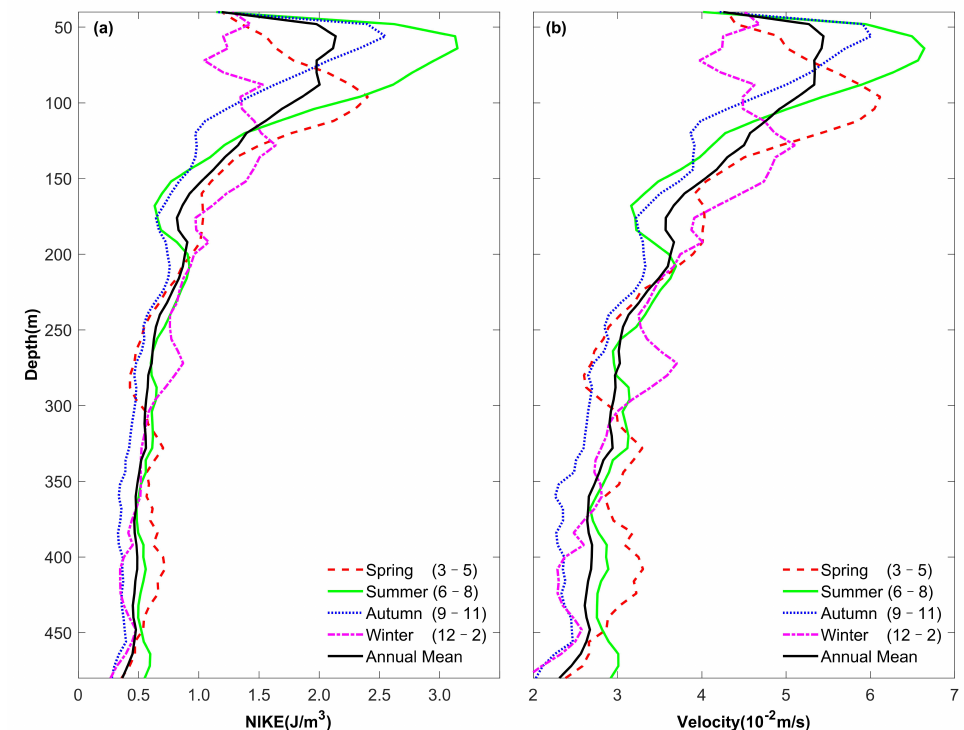
Figure 5. ( a ) Seasonal mean NIKE; ( b ) seasonal mean near-inertial